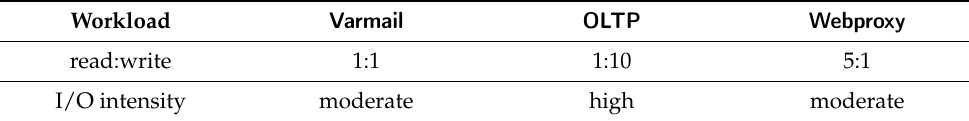
Table 1. I/O characteristics of three benchmark workloads.